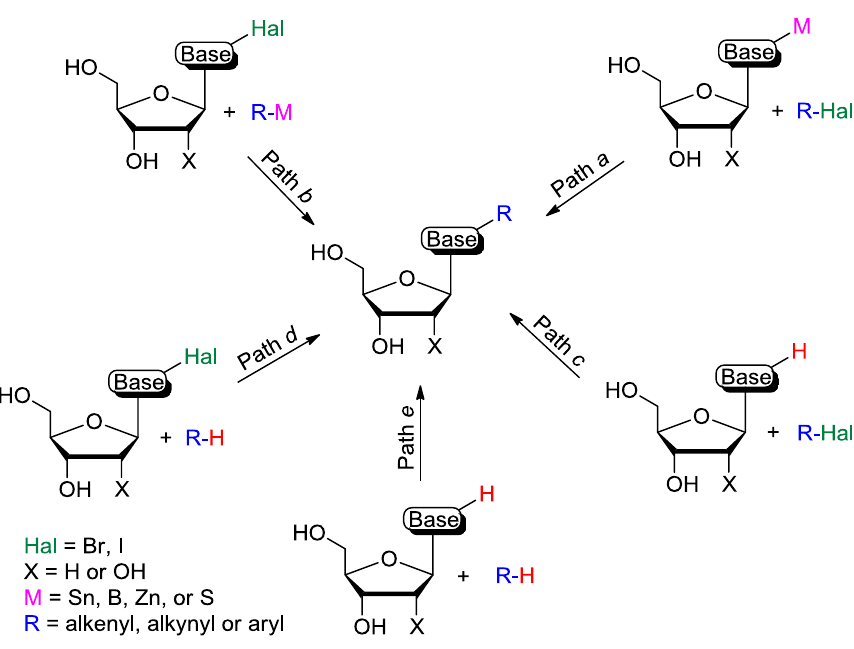
Figure 1. Transition metal catalyzed cross-coupling approaches towards the synthesis of base-modified nucleosides.